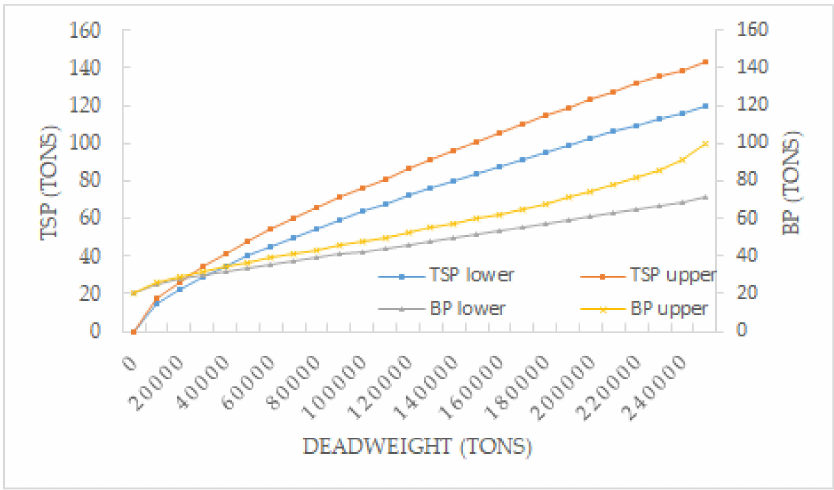
Figure 7. IMO TSP limits and the corresponding BP limits as per Model